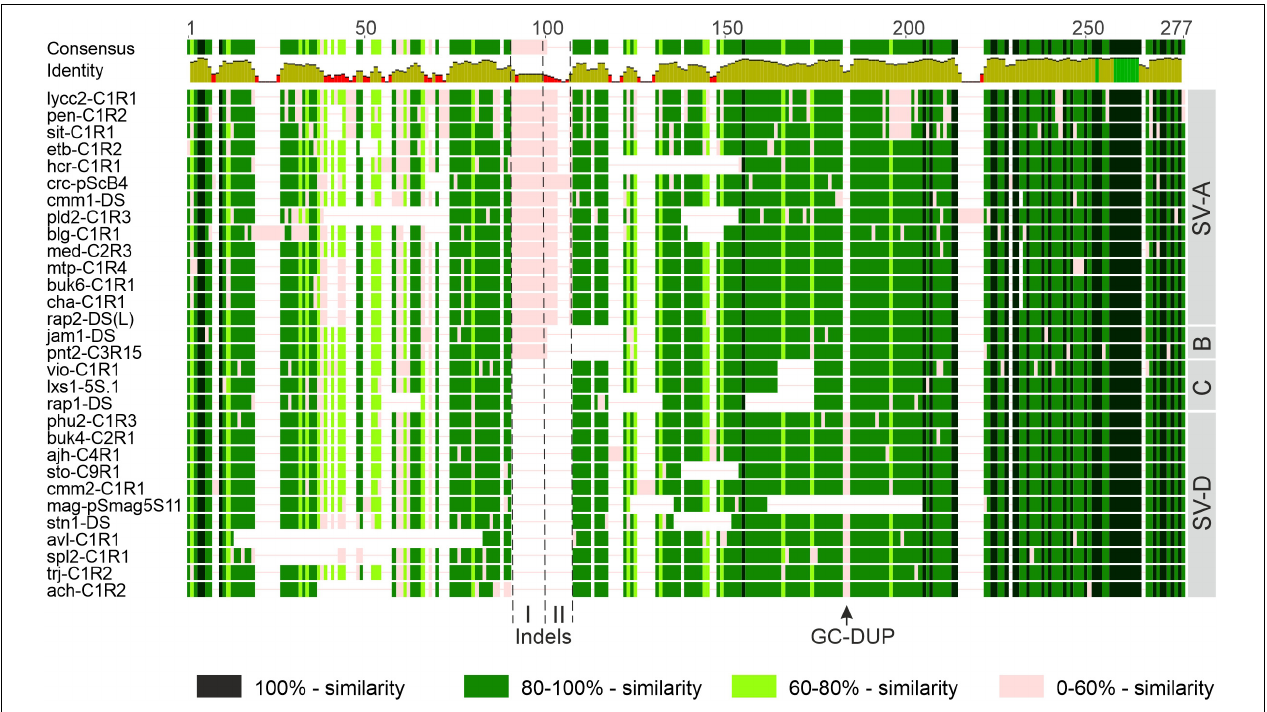
FIGURE 7 | Schematic representation of sequence alignment of the 5S IGS of sect. Petota members. The level of sequence similarity is shown in different colors. Positions of group-specific indels I and II and GC-duplication (GC-DUP) are indicated. Abbreviations of species names are given in Table 2 . Structural features of presented IGS sequences are indicated as structural variants (SVs)